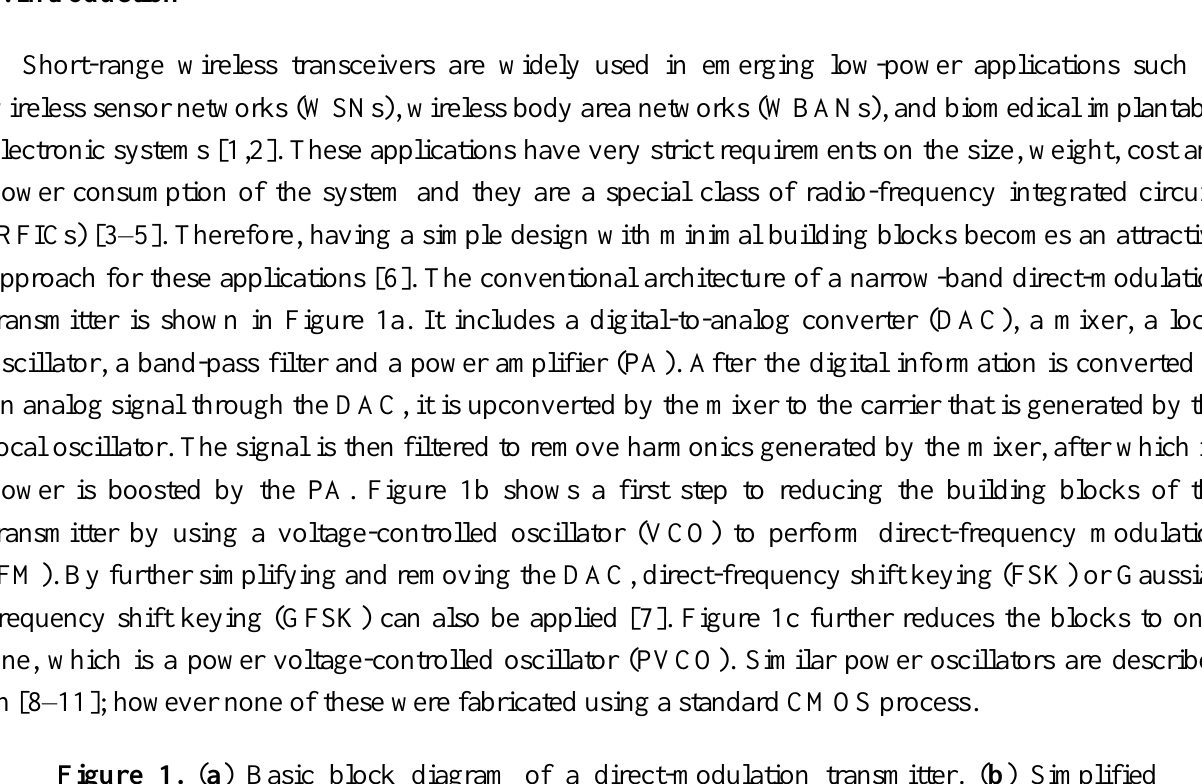
Figure 1. ( a ) Basic block diagram of a direct-modulation transmitter. ( b ) Simplified transmitter. ( c ) Single block transmitter using PVCO. ( d ) Single block transmitter using PVCO and